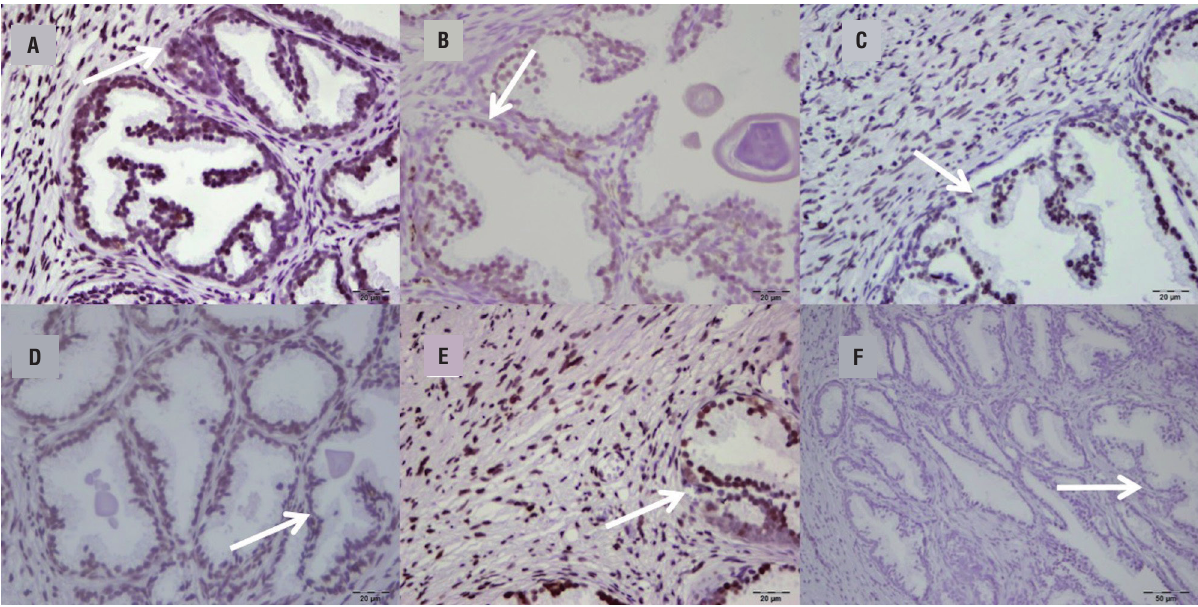
figure 2 - Apoptosis indexes in immunohistochemistry with TUNEL dyeing. A) The most apoptosis was observed in Group-1 (Arrow shows apoptotic cells), B) There was mild apoptosis in Group-2 (Arrow), c) Apoptotic gland in Group-3 (Arrow), D) Apoptotic glands around tissue in Group-4 (Arrow), E) Apoptosis in Group-5 (Arrow), f) The decreased level of apoptosis in Group-6 (control) (Arrow).